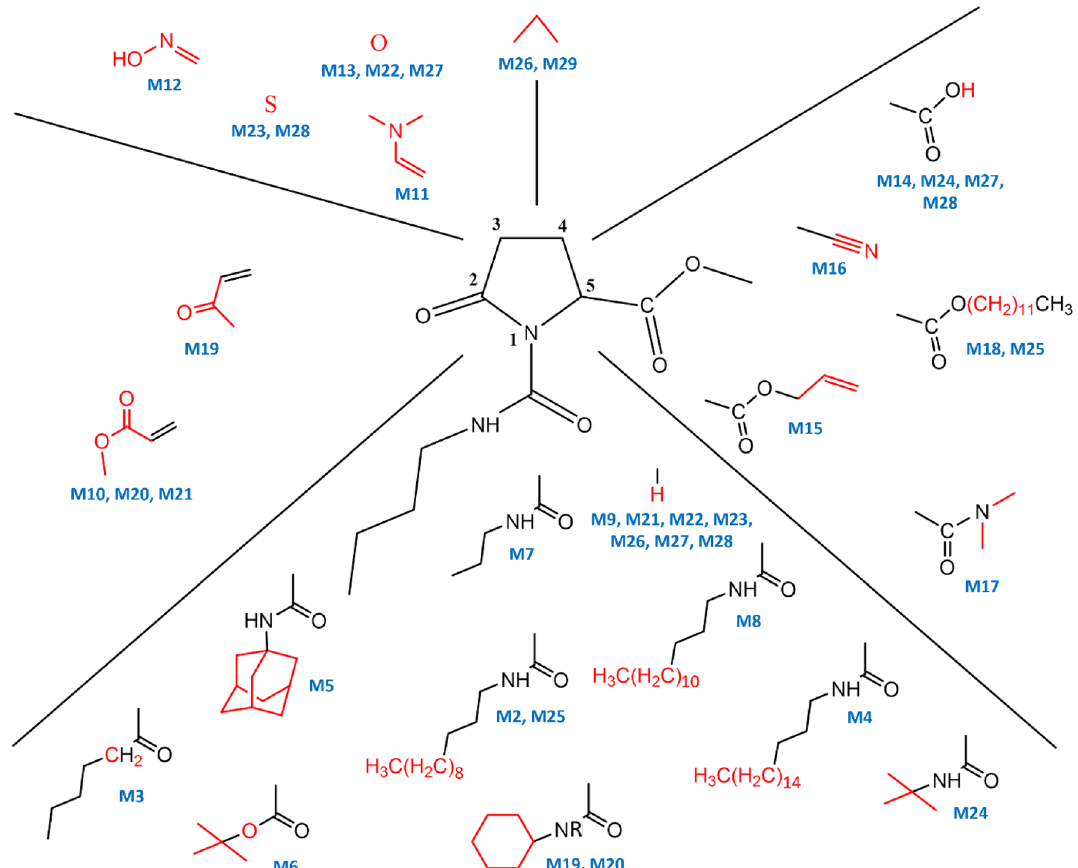
Figure 2. Pharmacophore of the molecule M1, showing the structure modifications performed on the different positions of the main nucleus of M1. All changes were done separately on all positions of the nucleus, except on position 4. Some molecules were modified in several positions